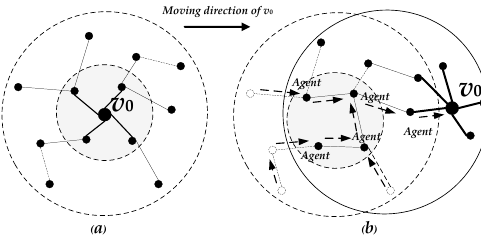
Figure 5. Packet forwarded by the agent